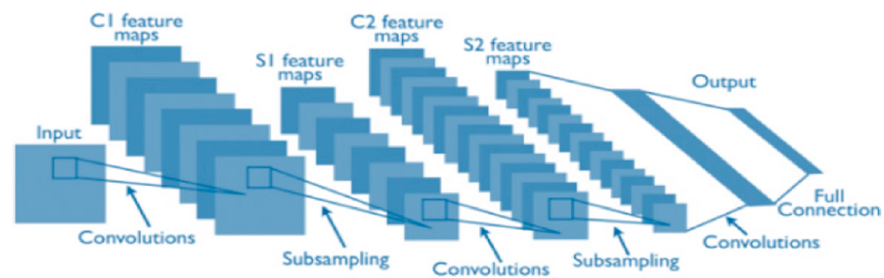
Figure 1. A typical convolutional network architecture Figure 1 A typical convolutional network architecture [23].